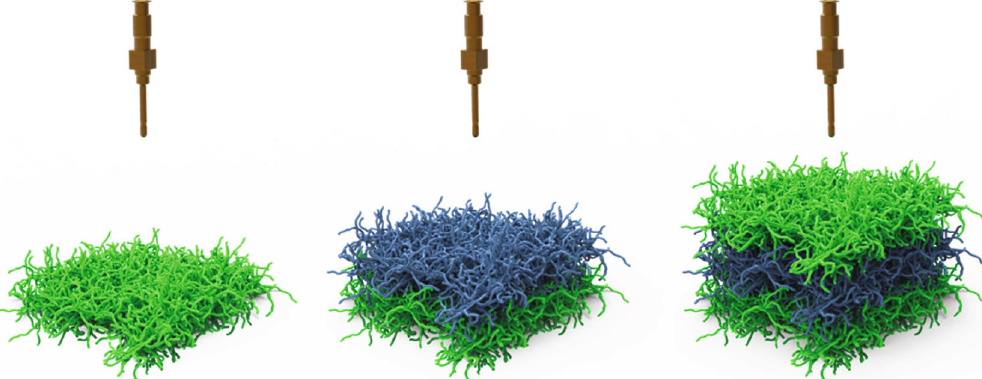
Figure 3: Schematic representation of the sequential electrospinning (from left to right, a new layer is added onto the previous